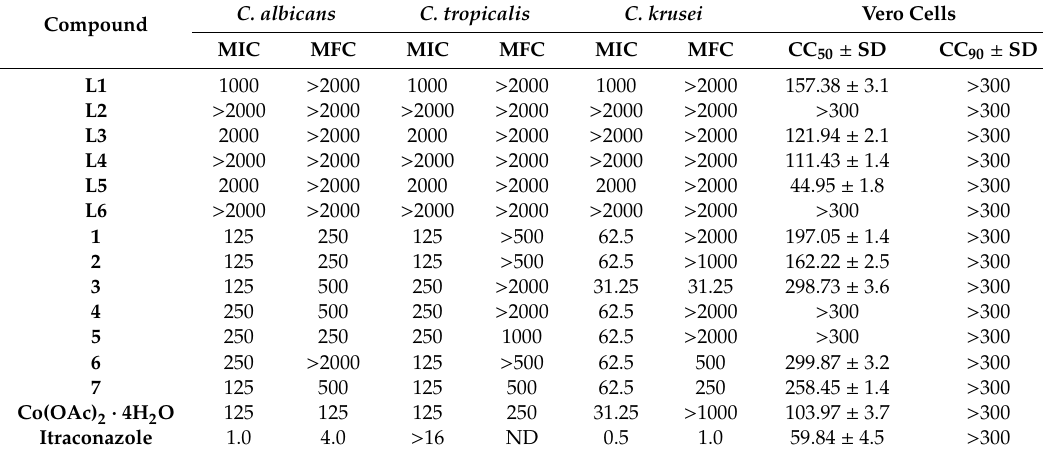
Table 4. Antifungal and cytotoxic activity